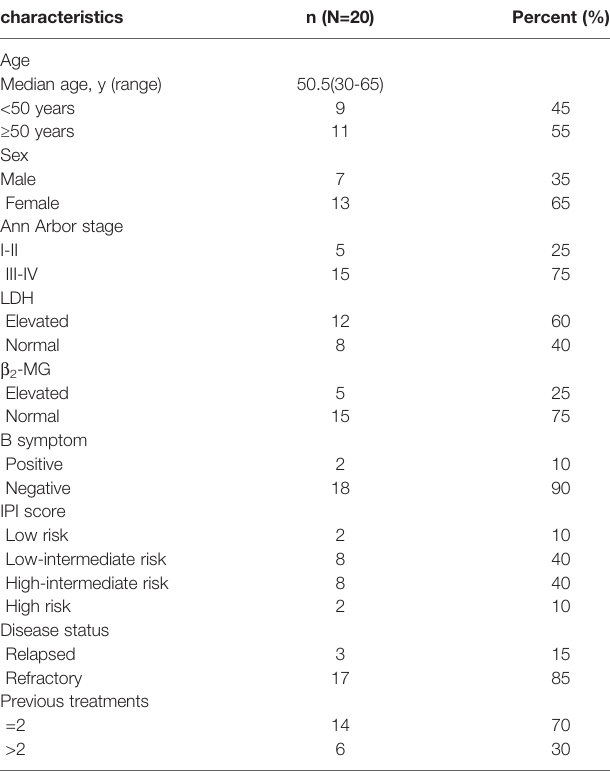
TABLE 1 | Baseline characteristics before recruited into our study.